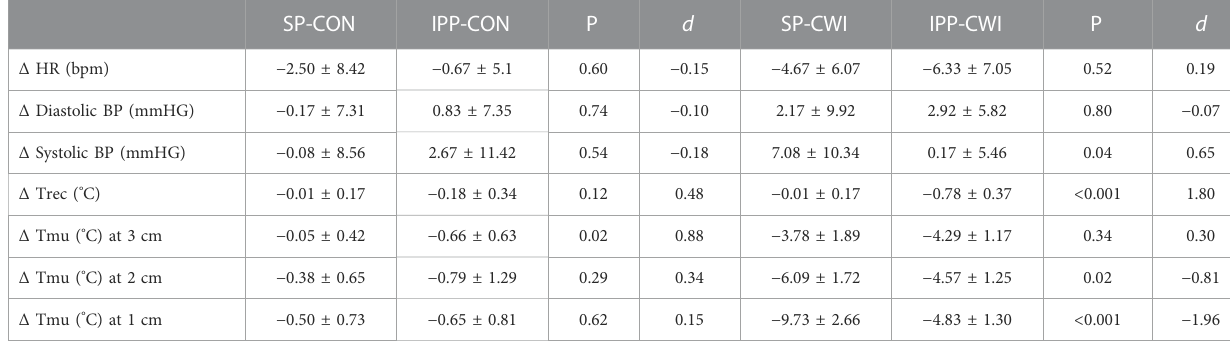
TABLE 1 Changes in the physiological measurements after the single and intermittent/prolonged